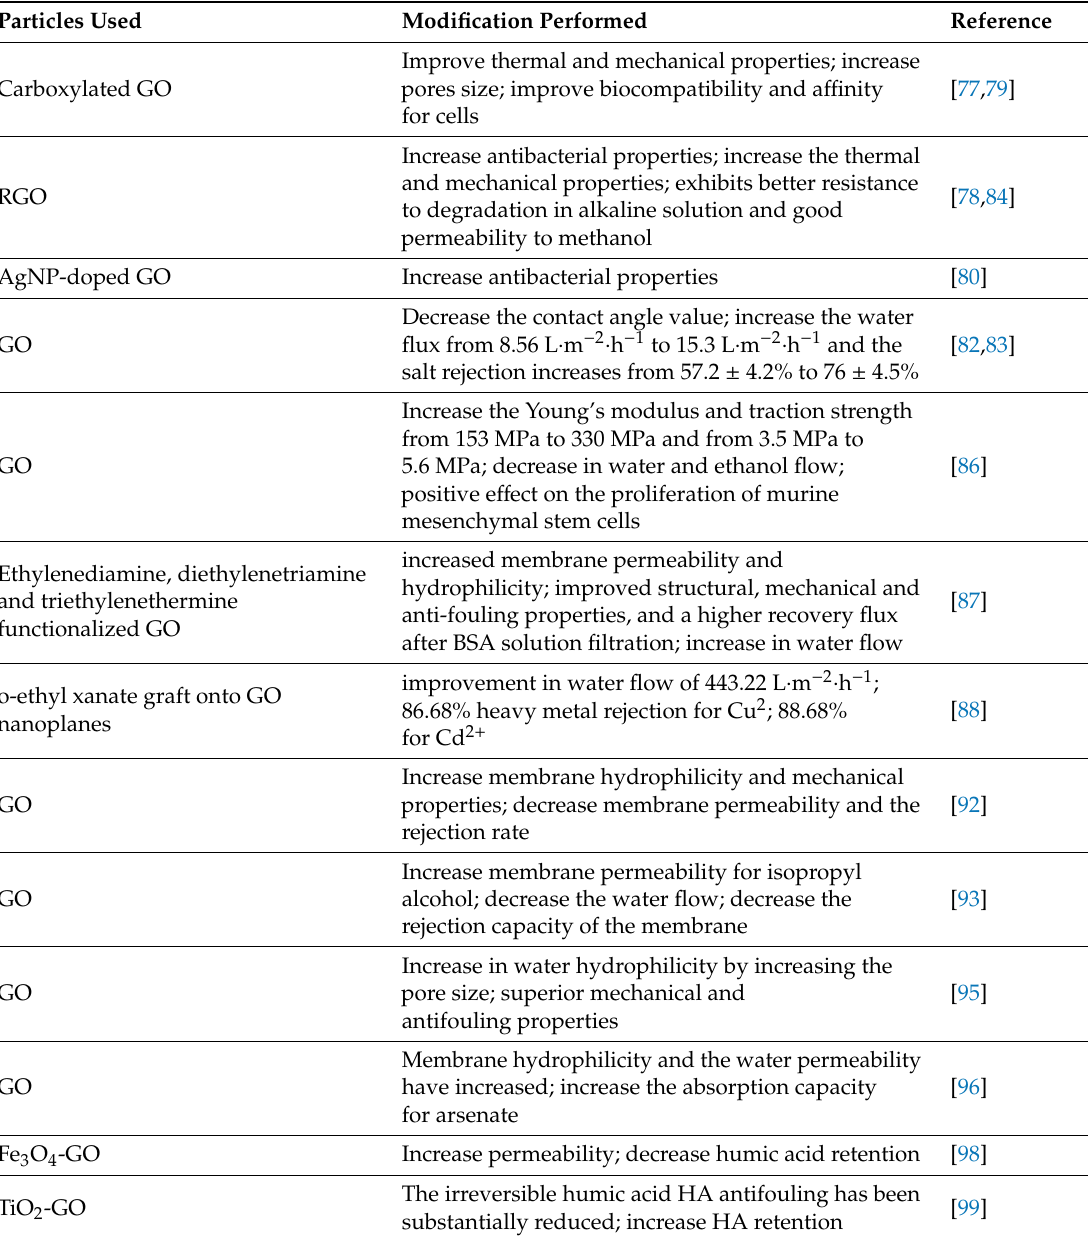
Table 2. Summarized applications for presented